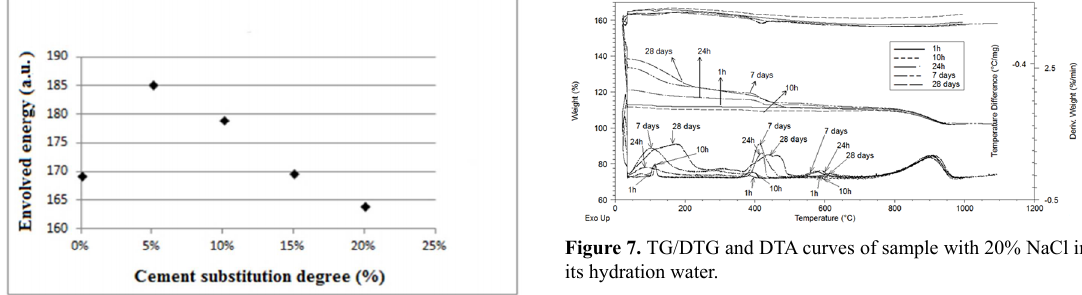
Figure 4. Envolved energy by samples with different percentage of NaCl in their hydration water for C